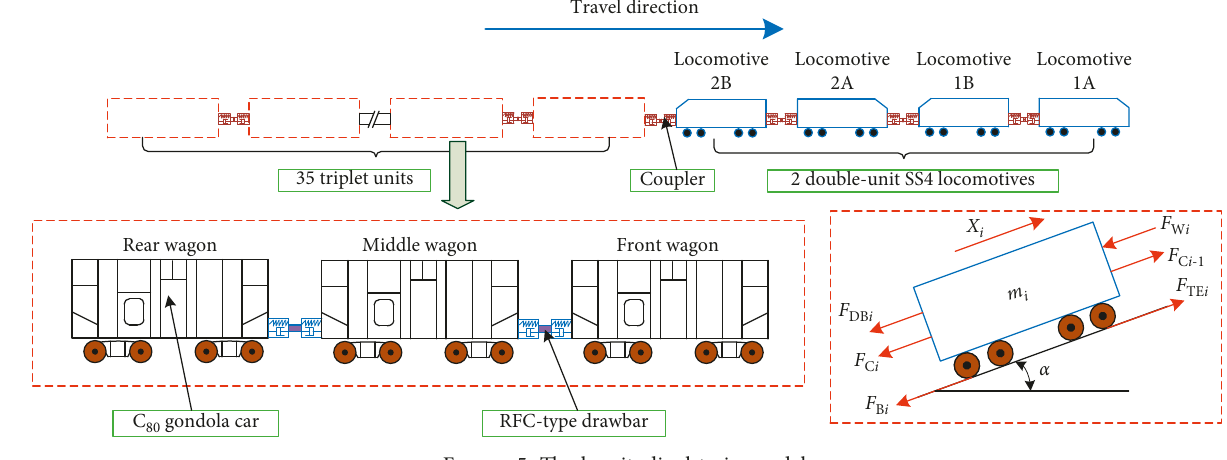
Figure 5: The longitudinal train model.